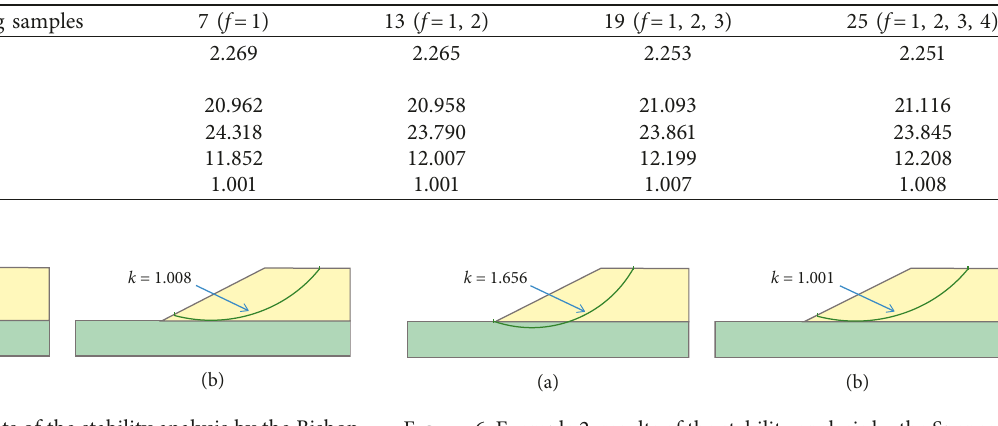
Figure 6: Example 2: results of the stability analysis by the Spencer 1.644) and (b) the method. Slip surface at (a) the mean point ( F s (cid:28) design point ( F s (cid:28)